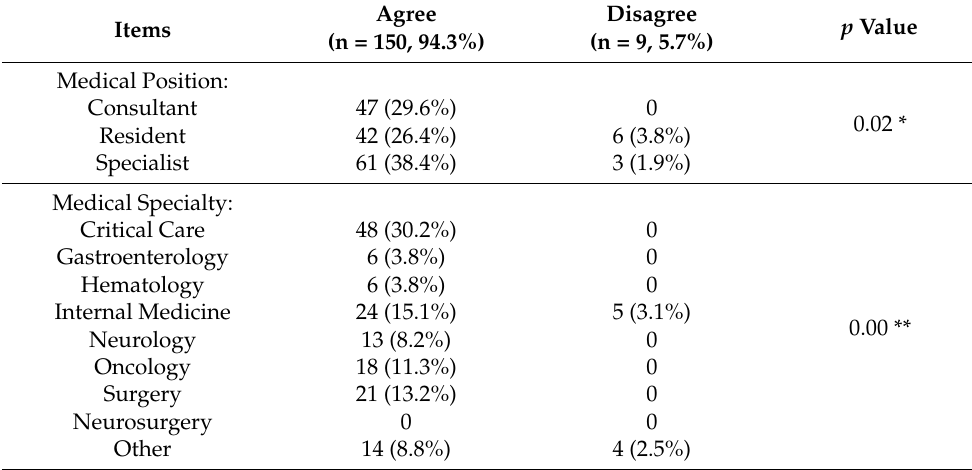
Table 4. Relation between physicians’ medical position and specialty and their willingness to consult a